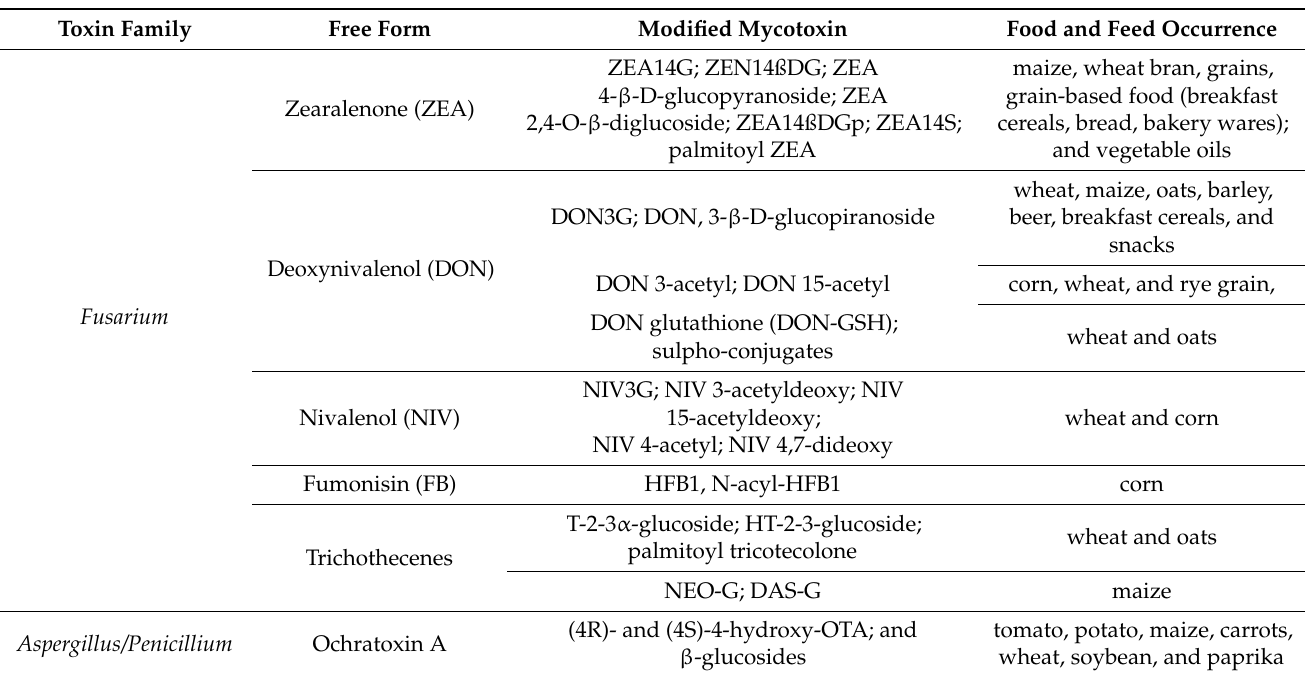
Table 1. Commonly modified